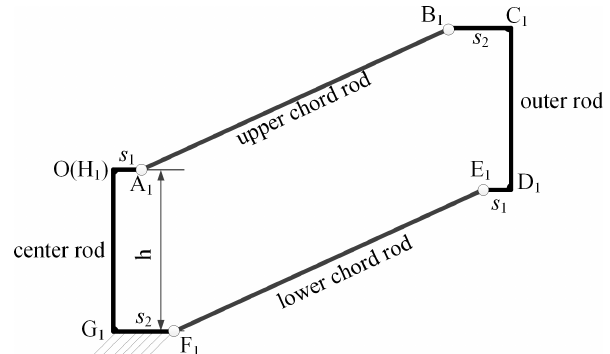
Figure 5. Geometrical parameters of parallelogram